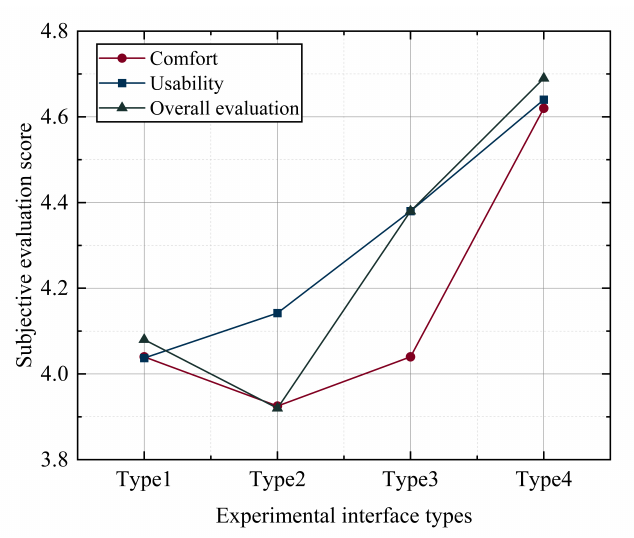
Figure 7. Subjective evaluation of different styles of